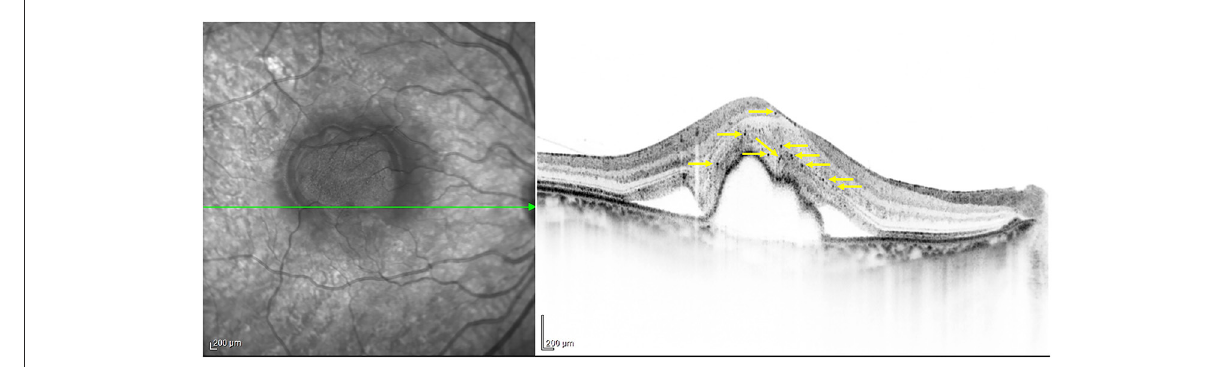
FIGURE1 HF, hyperreflective foci indicated by yellow